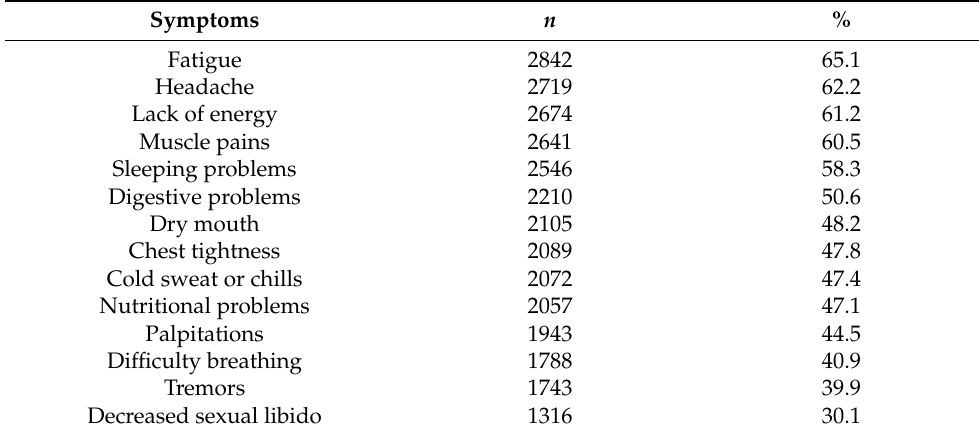
Table 2. Self-reported physical symptoms presented by the older adult during the COVID-19 pan- demic. Peru, 2021.